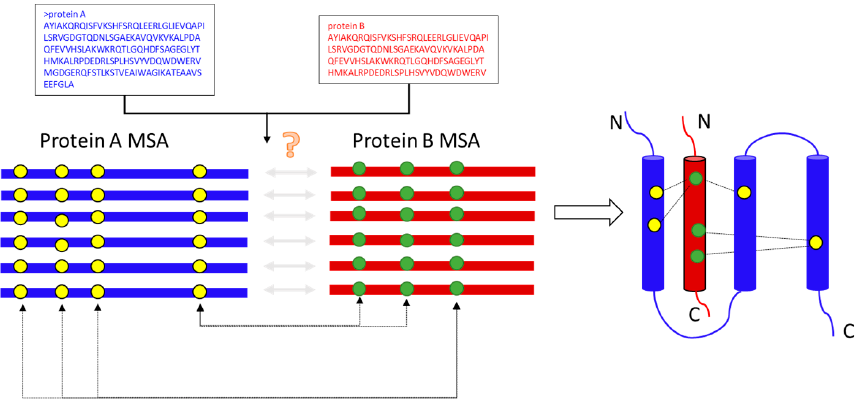
Figure 1. The flowchart of the building cpxMSA. The two circles (yellow and green) connected by double arrow lines indicate sites of coevolution ( left ) to identify evolutionary couplings between co-evolving inter-chain residue pairs ( right ).